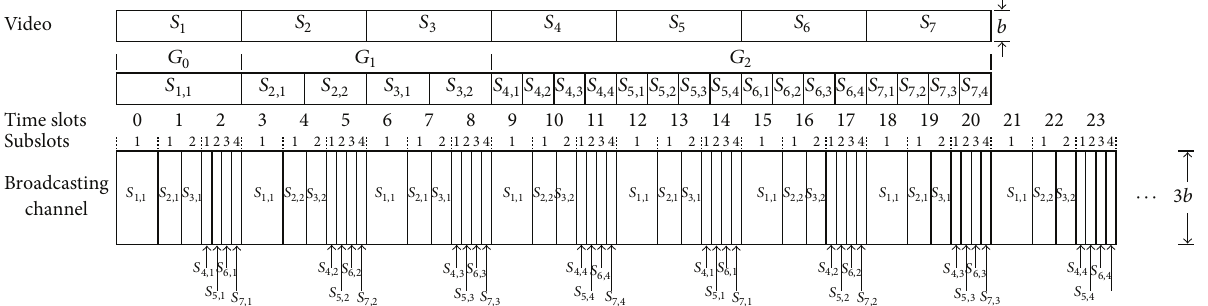
Figure 2: Segment partition and arrangement for the proposed